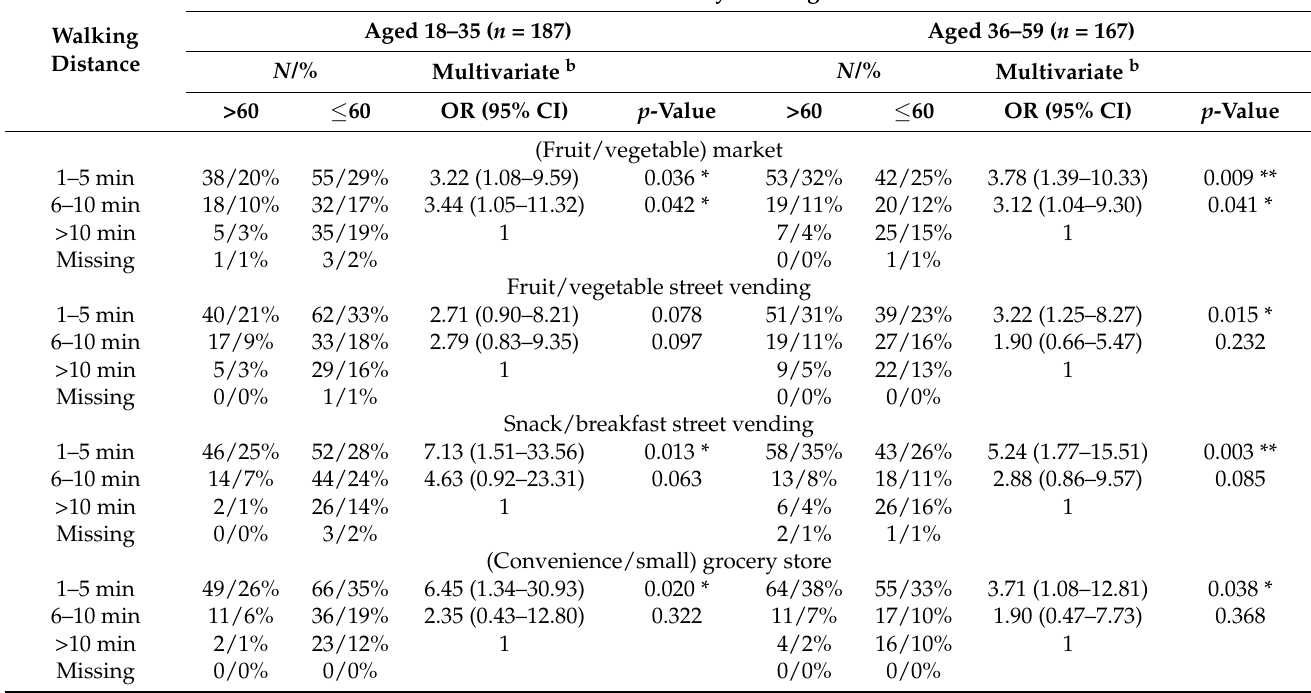
Table 4. Logistic regression analysis for the associations between residential food environment variables and perceived daily walking duration by age